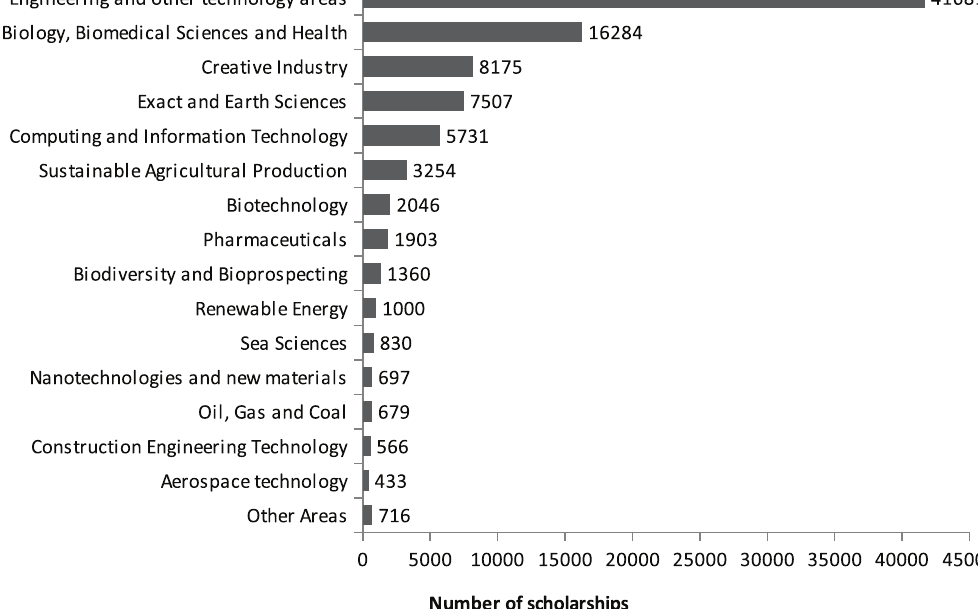
Figure 5 - Number of undergraduate SwB students for each of the Program’s priority areas (Capes and CNPq).